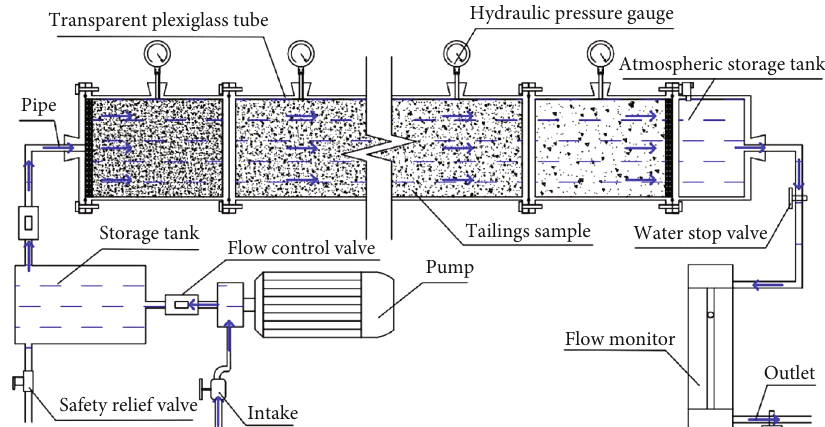
Figure 3: Schematic diagram of the permeability coe ffi cient measuring device for layered tailings.